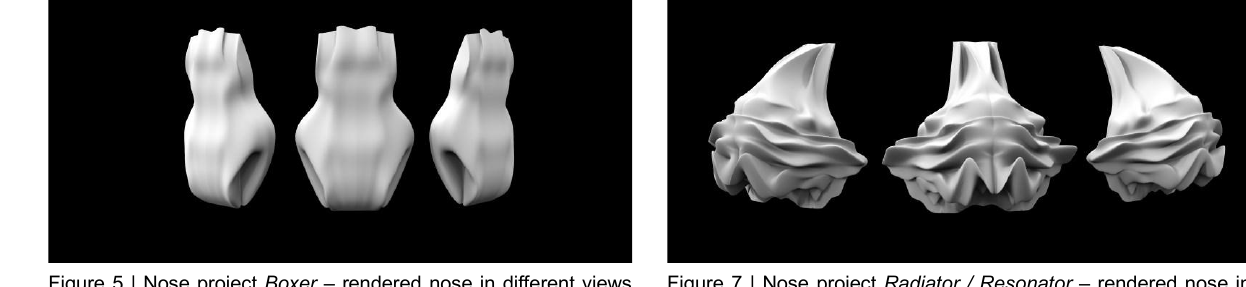
Figure 7 | Nose project Radiator / Resonator – rendered nose in different